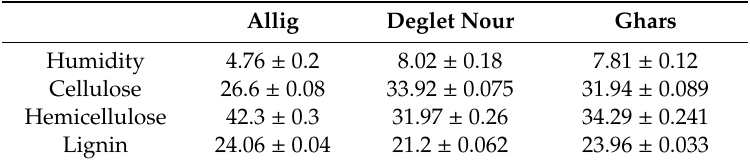
Table 1. Physicochemical composition of three varieties of date seeds (Allig, Deglet Nour, Ghars). Allig Deglet Nour Ghars